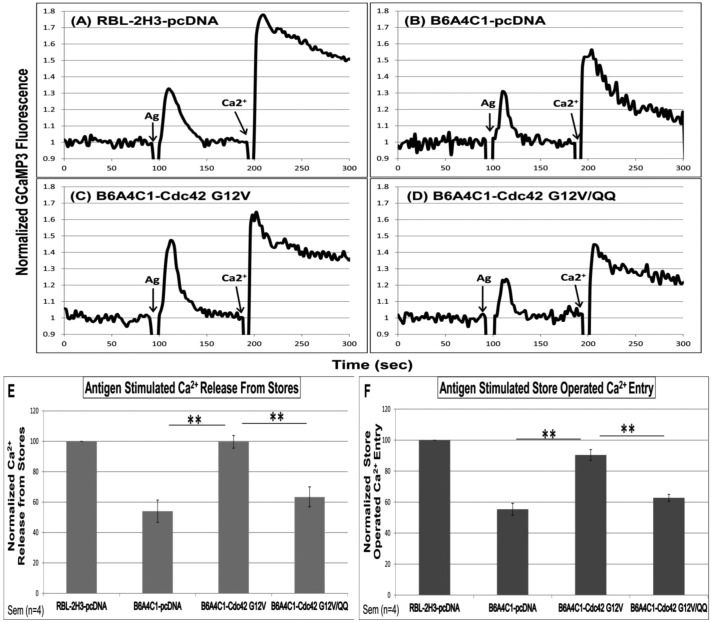
Carboxyl terminal di-arginine motif of Cdc42 is necessary for reconstituting Ca2+ mobilization in B6A4C1 cells.IgE-sensitized RBL-2H3 mast cells expressing pcDNA and GCaMP3 (A), and B6A4C1 mast cells expressing pcDNA and GCaMP3 (B), Cdc42 G12V and GCaMP3 (C), or Cdc42 G12V/QQ and GCaMP3 cells (D) were stimulated in Ca2+-free BSS with 0.2 µg/ml of DNP-BSA (Ag) at 100 seconds, then 1.8 mM Ca2+ was added at 200 seconds. The resulting responses represent Ca2+ release from stores and store operated Ca2+ entry (SOCE), respectively. (E,F) Summary of four independent experiments monitoring changes in GCaMP3 fluorescence due to stimulated Ca2+ release from stores (E) and SOCE (F). Error bars indicate ±s.e.m. (**P<0.01).